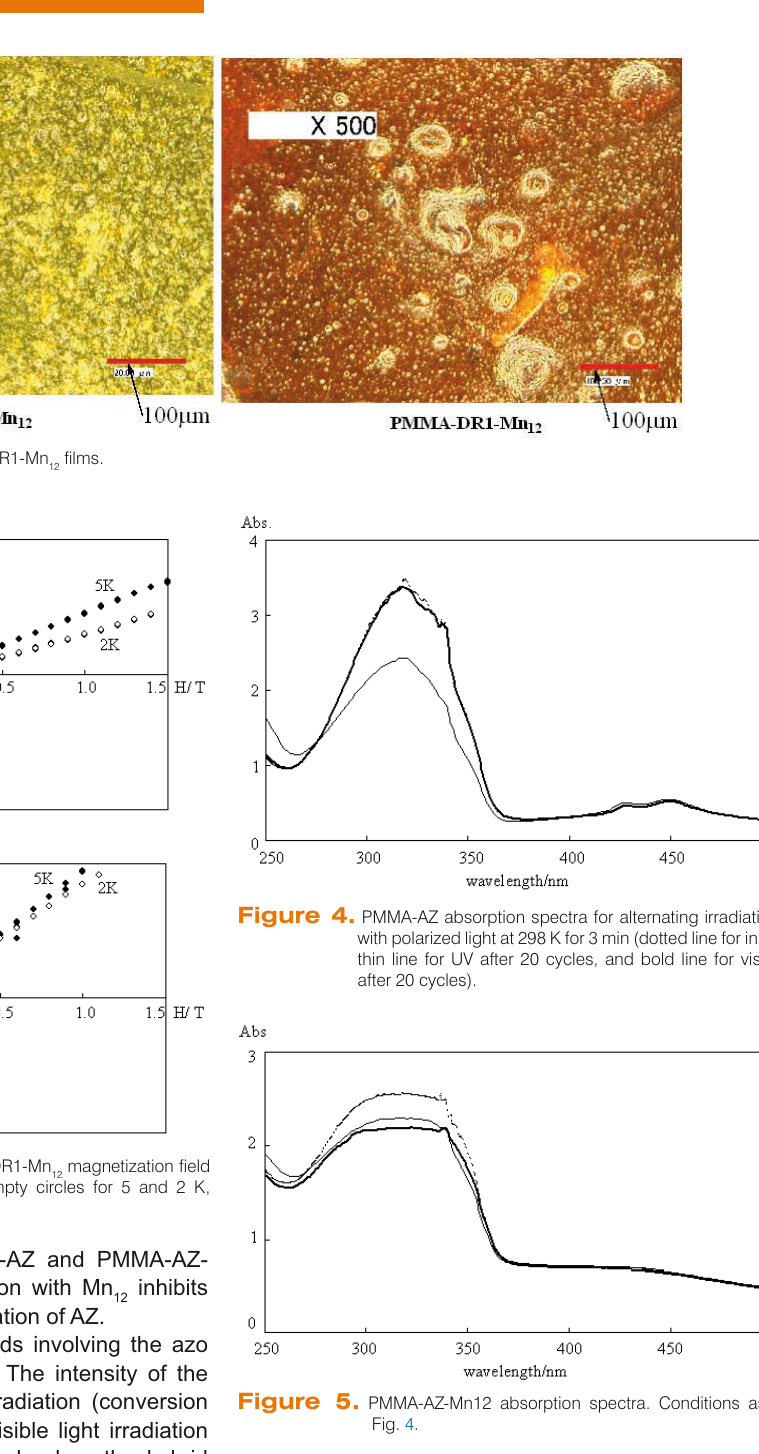
Figure 5. PMMA-AZ-Mn12 absorption spectra. Conditions as in Fig. Figs. 6 and 7 show absorption spectra of PMMA- . In a PMMA matrix, DR1 DR1 and PMMA-DR1-Mn 12 azo groups show a relatively weak π-π* band around 280 nm and a stronger n-π* band around 493 nm. The n-π* intensity decreases upon formation of the cis form and increases with formation of the trans. On the